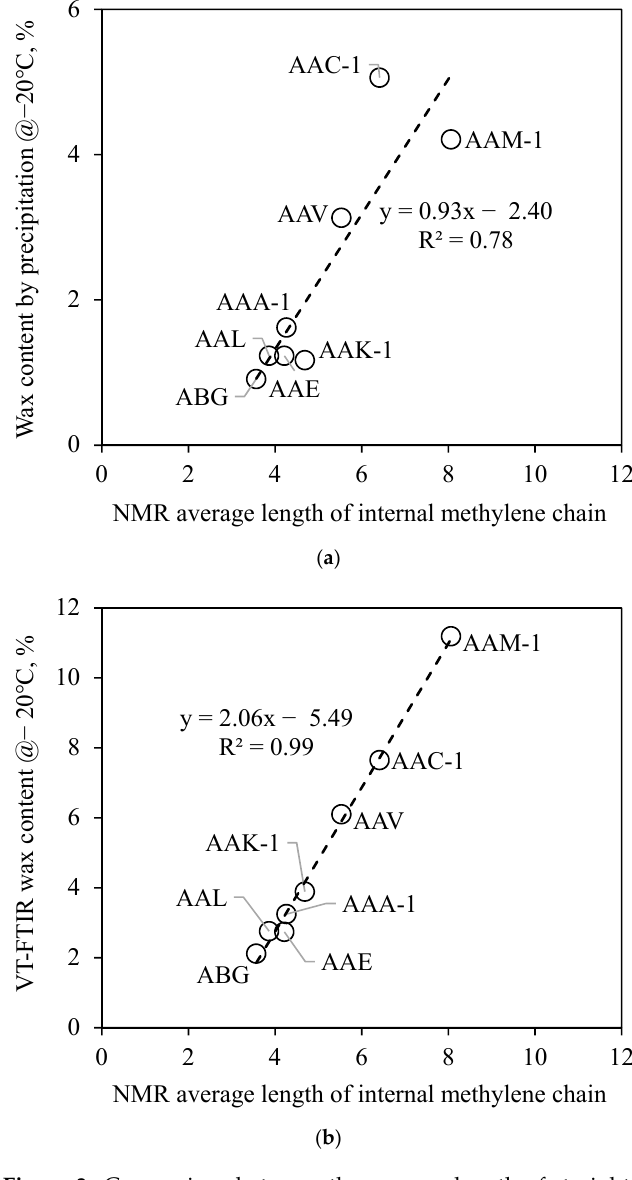
Figure 3. Comparison between the average length of straight internal methylene carbon of long paraffinic chain terminated by a methyl group and wax contents obtained using ( a ) precipitation and ( b ) VT-FTIR methods.